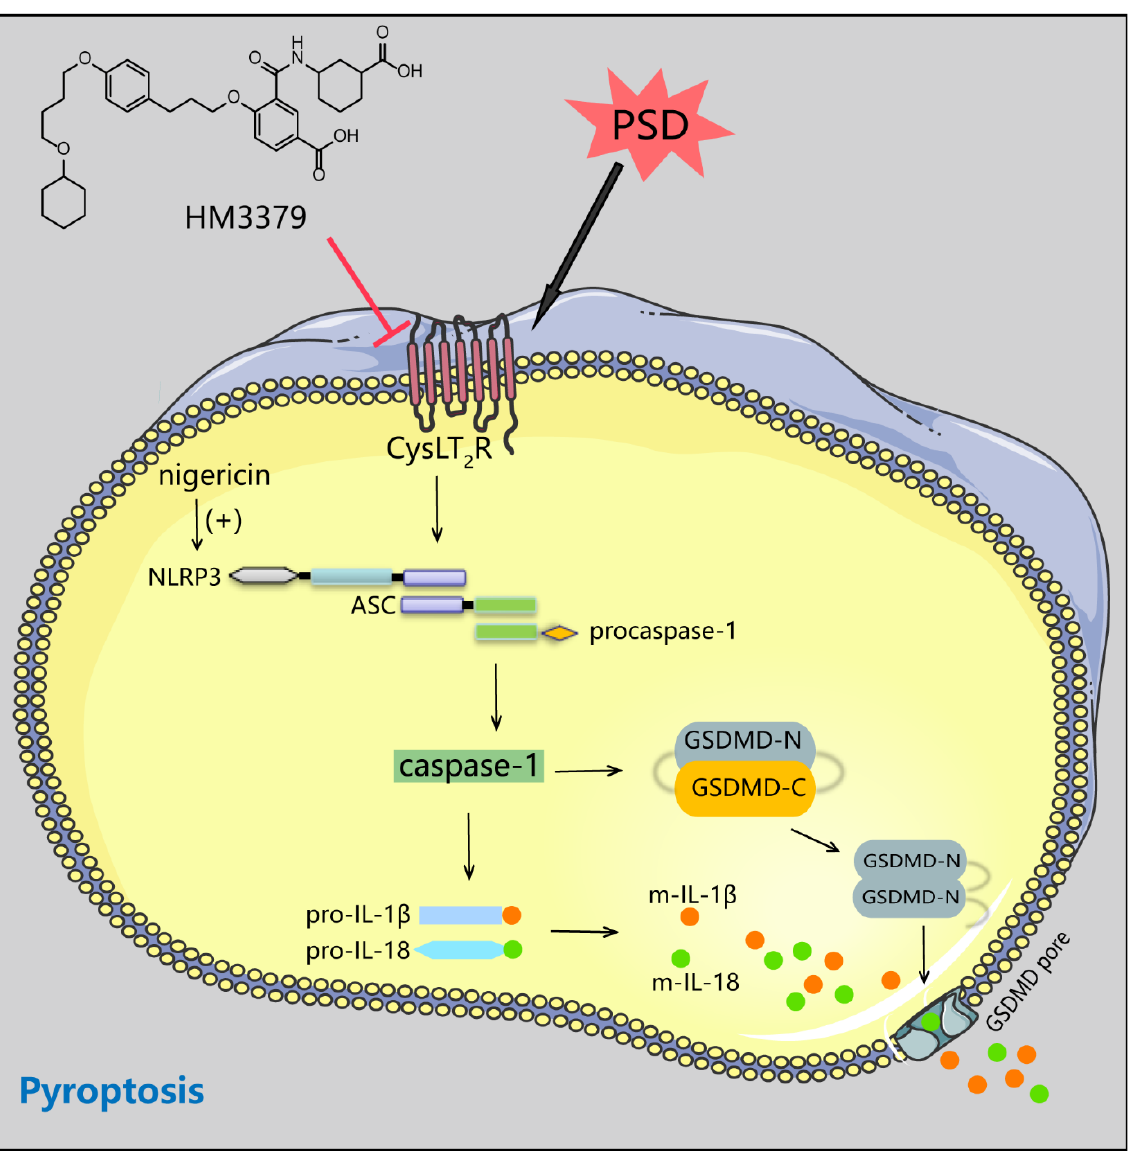
Figure 7. Schematic diagram for of HM3379 inhibition of the NLRP3 inflammasome/pyroptosis pathway ameliorating post ‐ stroke depression in gerbils.